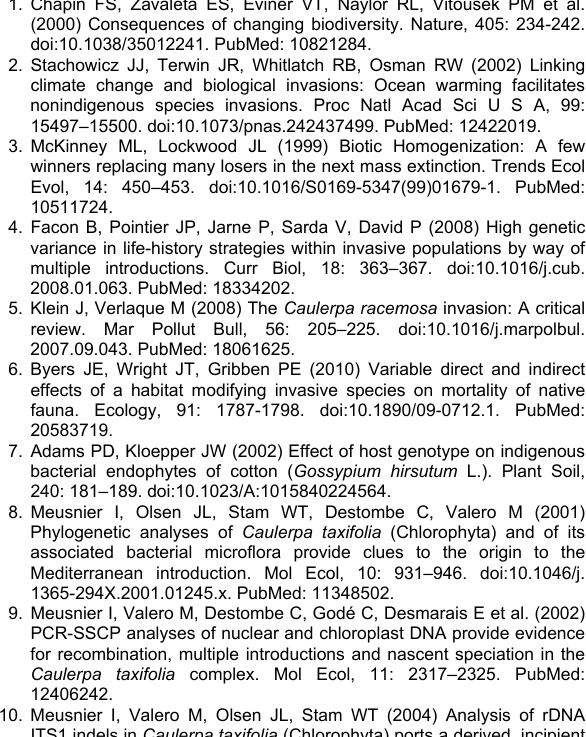
Table S3. Statistical results of One-way ANOSIM with Bray-Curtis distance measures applied to each group